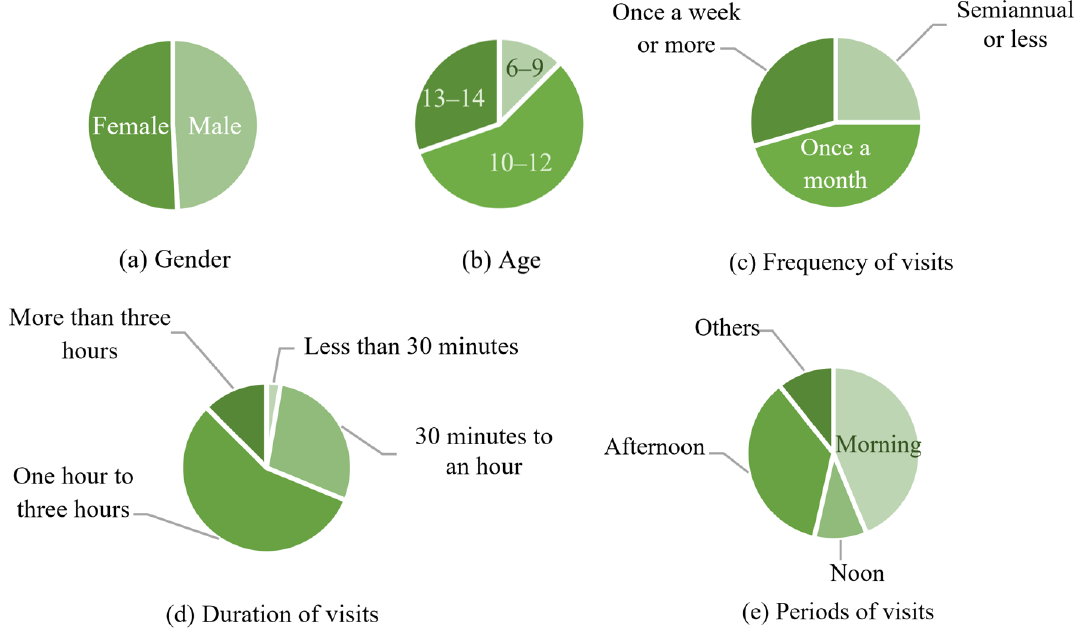
Figure 4. Description of surveyed children’s basic characteristics and activities in the urban forest park. ( a ) Gender; ( b ) age; ( c ) frequency of visits; ( d ) duration of visits; and ( e ) periods of visits. All items were set as single-choice questions.